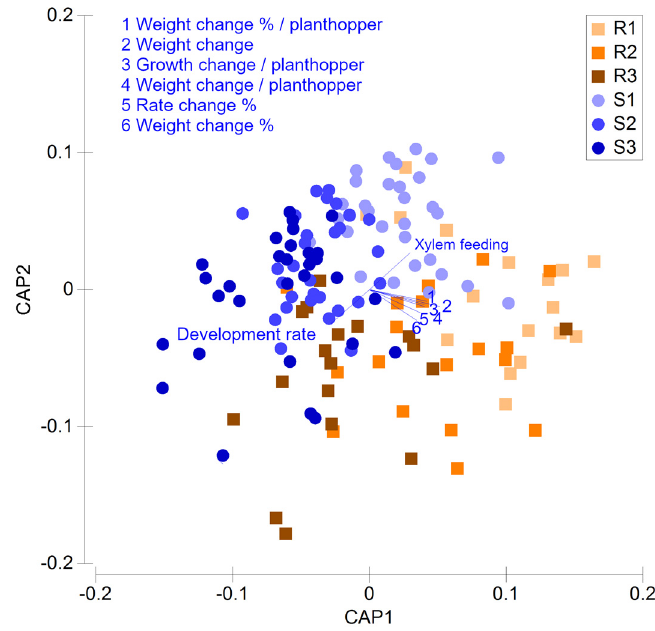
Figure 3. Canonical Analysis of Principal Coordinates (CAP) depicting differences in herbivore fitness and plant damage parameters obtained through multiple bioassays. Squares represent resistant varieties/lines, whereas circles represent susceptible varieties/lines. Nitrogen regimes (1 = 0 added N, 2 = 80 Kg N ha − 1 , and 3 = 150 Kg N ha − 1 ) are represented by increasing color darkness. Overlayed vectors (in blue) represent the correlations (Pearson’s correlation coefficient > 0.6) between rice lines and the CAP axes, where vector length and direction reflect the increasing values of correlation and parameter values, respectively.